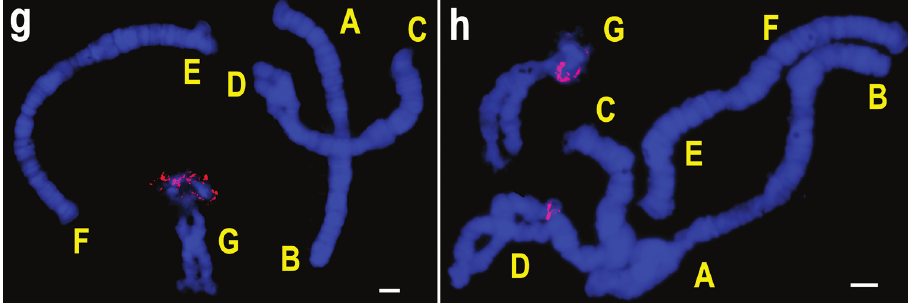
Figure 3. Continued. FISH of rDNA probes on polytene chromosomes of species from the subgenus Chironomus with multiple localization of hybridization sites. g Ch. balatonicus with one NOR h Ch. bala- tonicus with additional NOR in arm D. Letters designate chromosomal arms. Green arrows show sites of weak hybridizations signals. Bar = 10